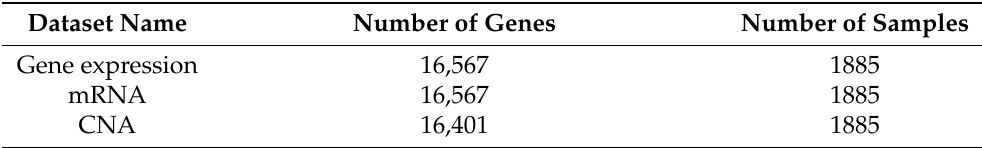
Table 2. Datasets after sample and gene